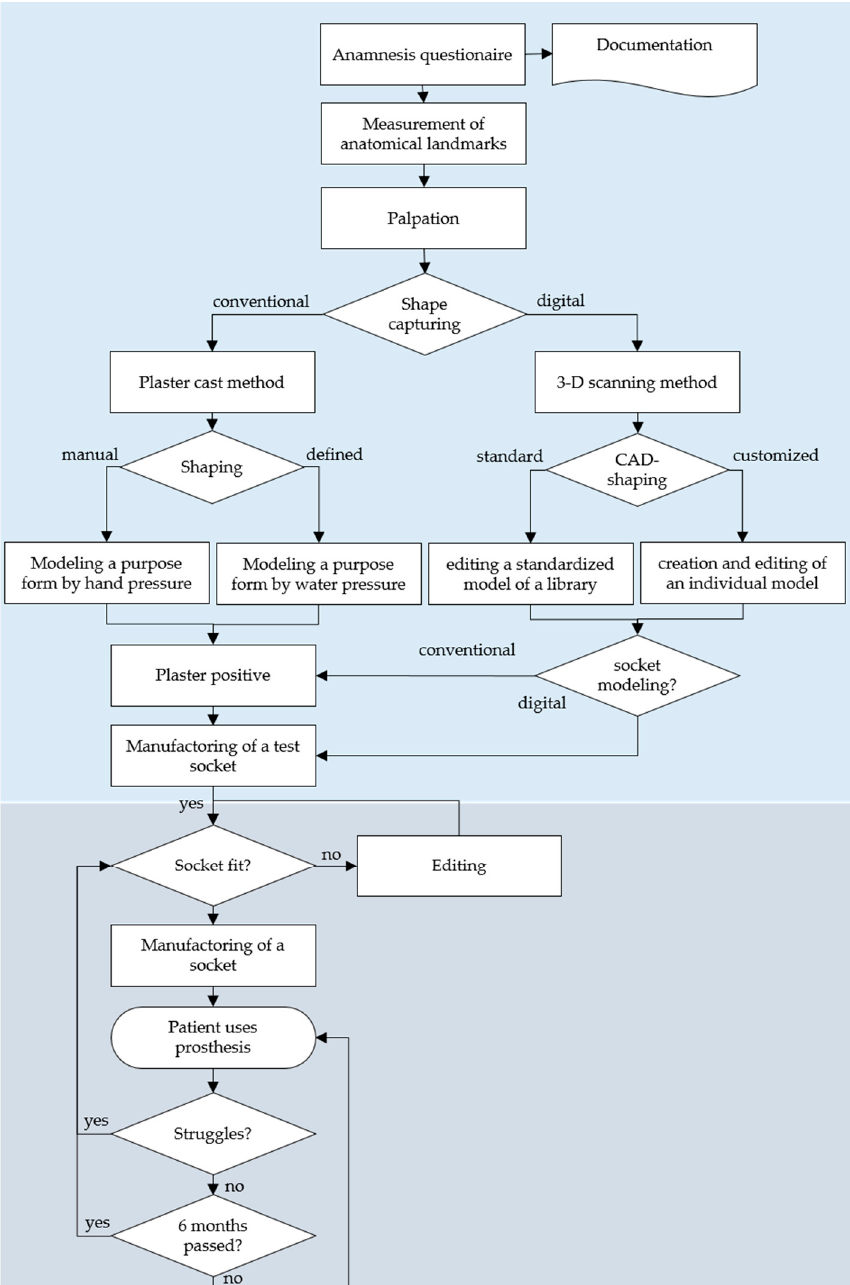
Figure 3. Course of action of the socket manufacturing process.